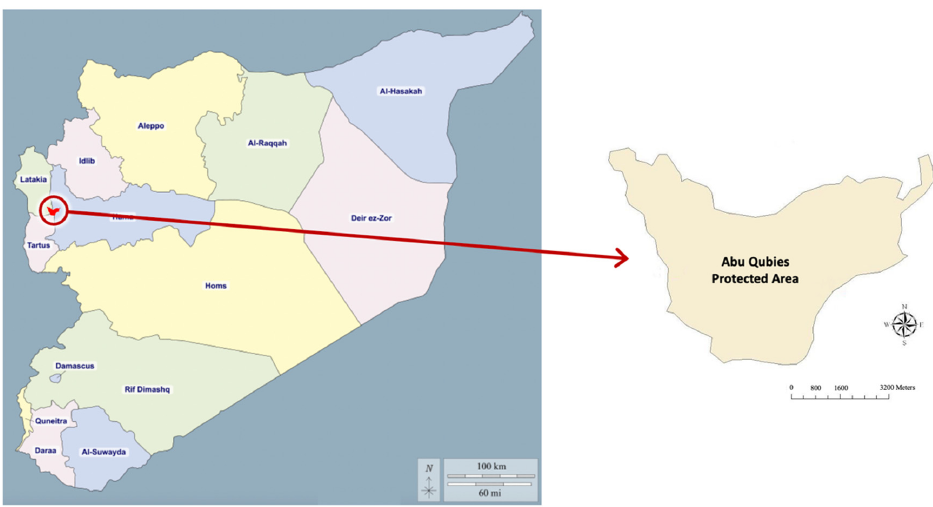
Figure 1. Abu Qubies protected area, Syria (case study).